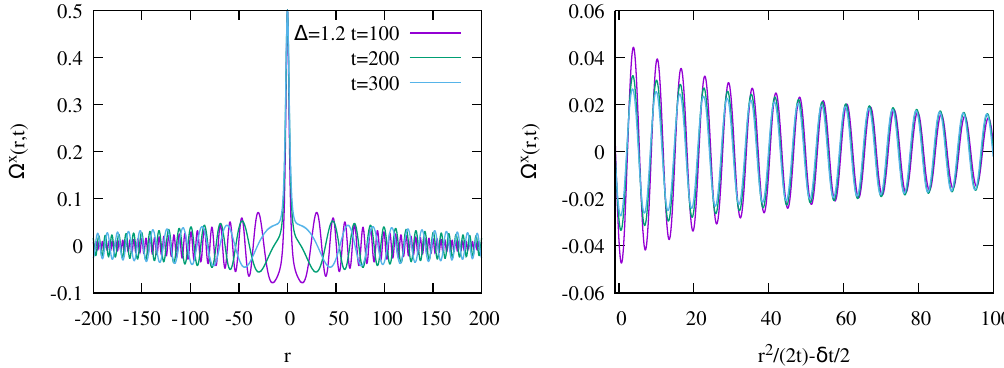
Figure 5: Large distance behavior of Ω x ( r , t ) for ∆ > 1 and three different times. Left panel: Ω x ( r , t ) as a function of the position r for ∆ = 1.2. Right: Same data plotted as a function of r 2 / ( 2 t ) − t δ/ 2 with δ given in Eq (6). The latter shows that the phase of the oscillations is well described by the argument of the exponential in Eq. (29).